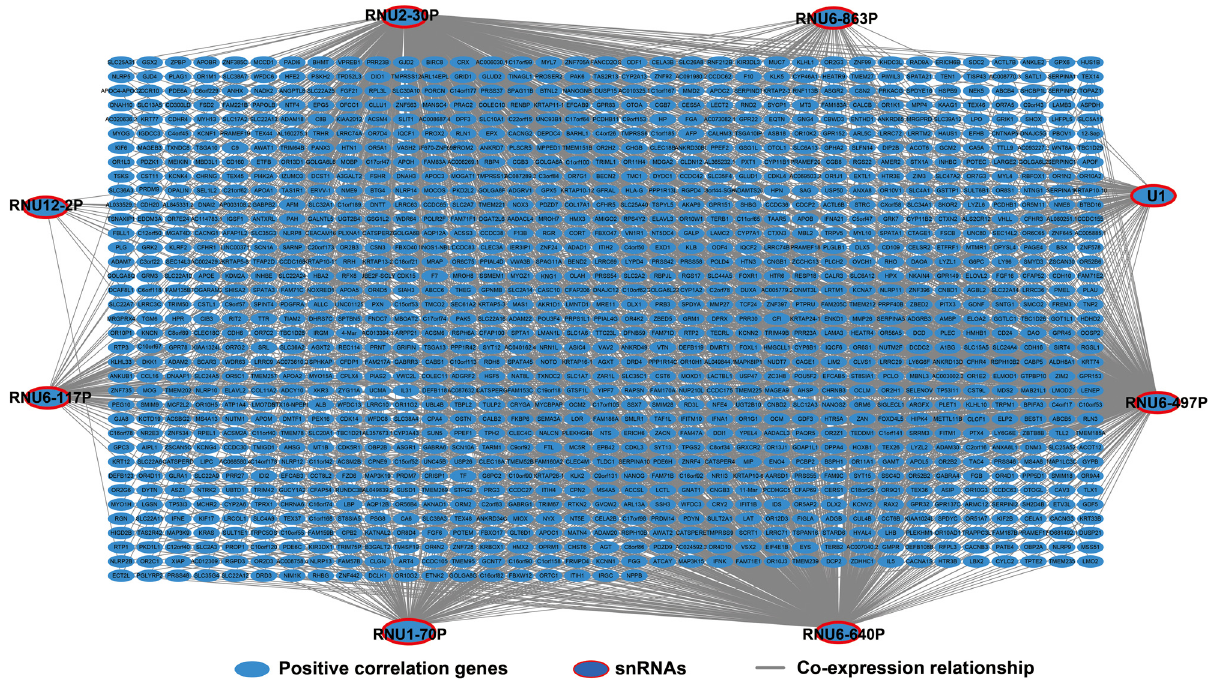
Figure 5: Interaction network of prognostic snRNAs and mRNA co - expression